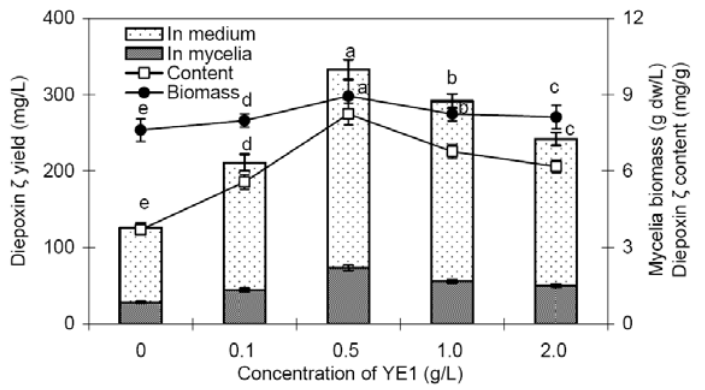
Figure 4. Effects of YE1 applied to the medium on day 3 on mycelia growth and diepoxin ζ production in liquid culture of endophytic fungus Dzf12. The period of culture was 13 days; The error bars represented standard deviations, n = 3; Different letters ( i.e ., a-e) indicated significant differences among the treatments at p = 0.05 level. Only the significant differences of the mycelia biomass and total diepoxin ζ yield were indicated.